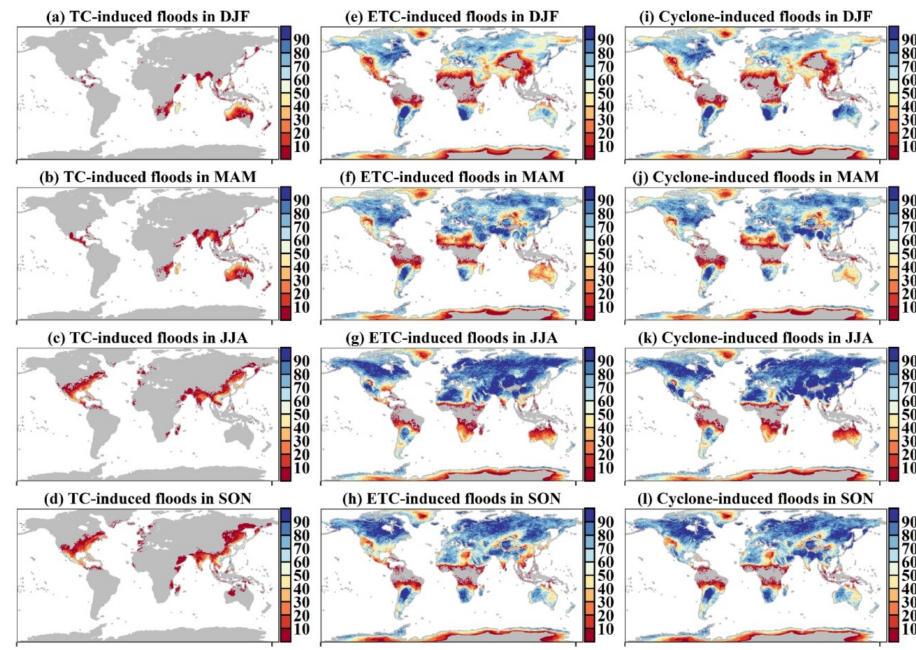
Figure 6. Contributions (%) of tropical cyclones (TCs, a – d ), extratropical cyclones (ETCs, e – h ), and all cyclones ( i – l ) to seasonal floods in simulations sampled by block maximum (BM) method. The four seasons are DJF (December–February), MAM (March–May), JJA (June–August), and SON